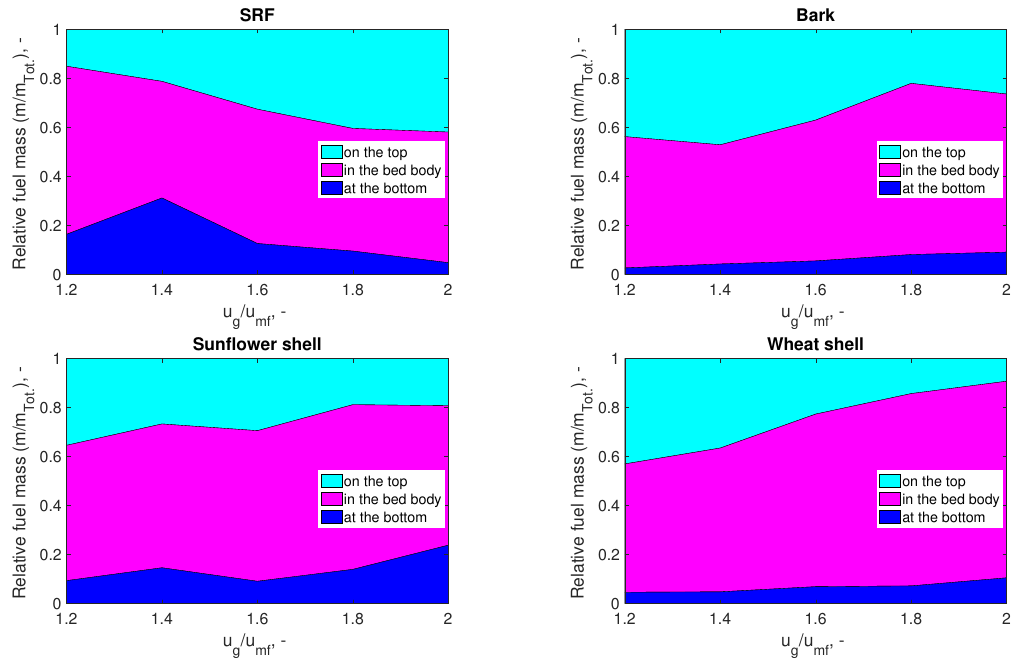
Figure 9. Vertical distributions ( relative mass fractions ) of the investigated biomass fuels in binary-mixture beds at different fluidization